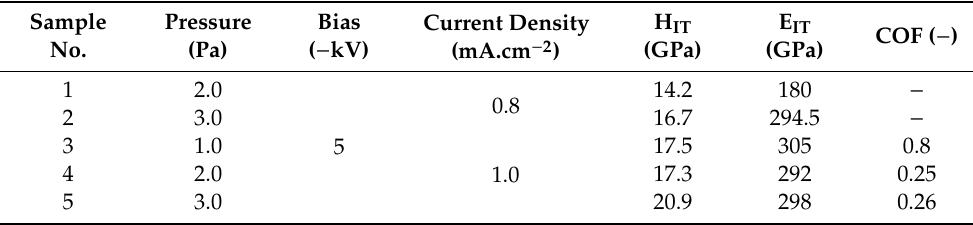
Table 1. The selected technological parameters and properties of the optimized WC / C coatings with the use of W carbonyl as a precursor.